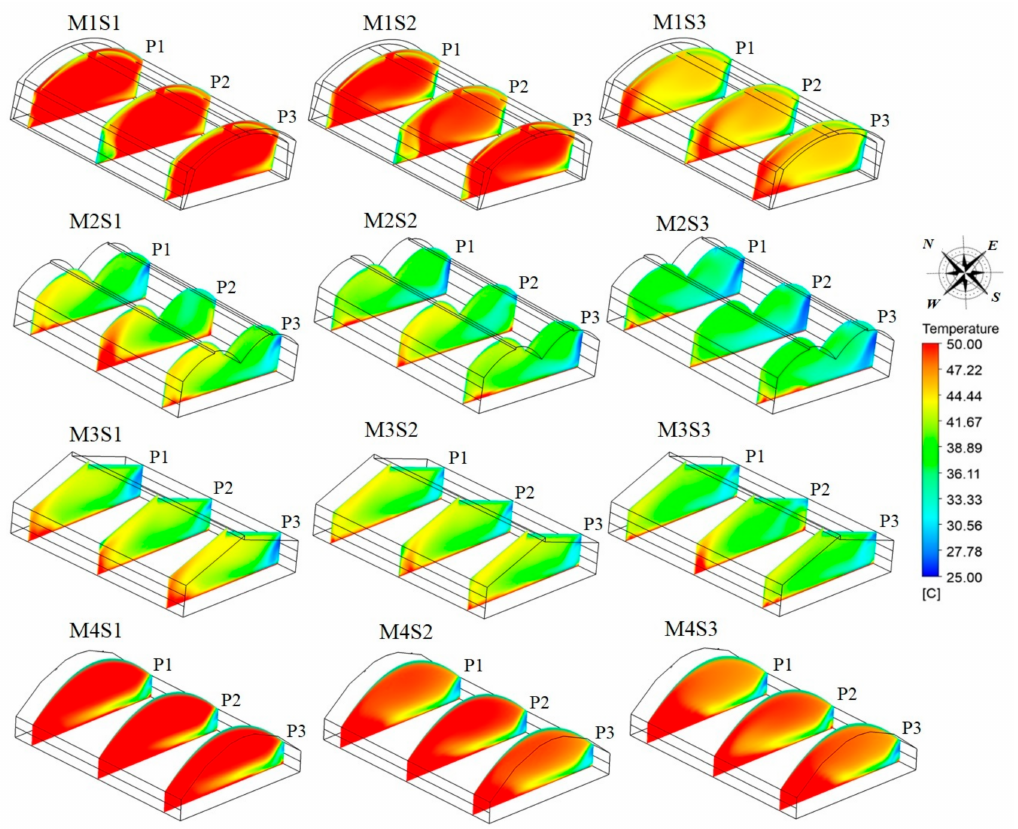
Figure 6. Spatial temperature distribution for all simulated